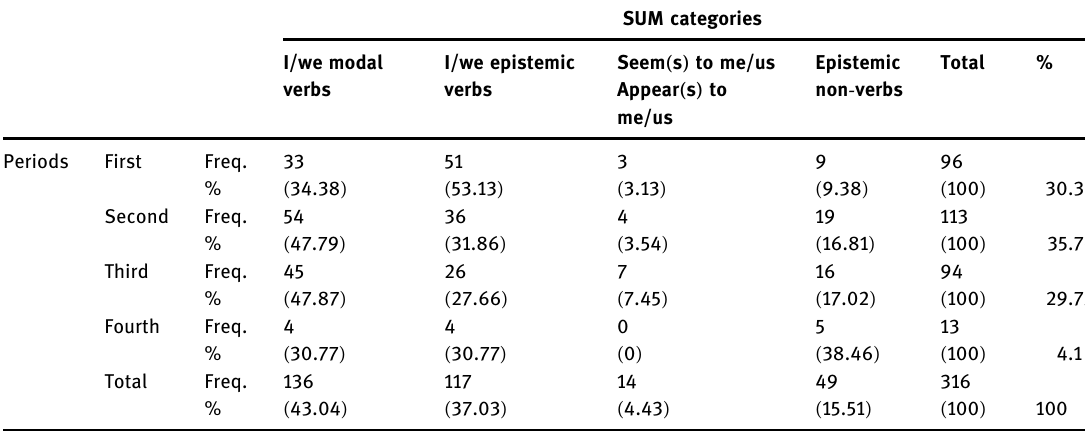
Table 5: Frequencies and percentages of SUM categories in each time period